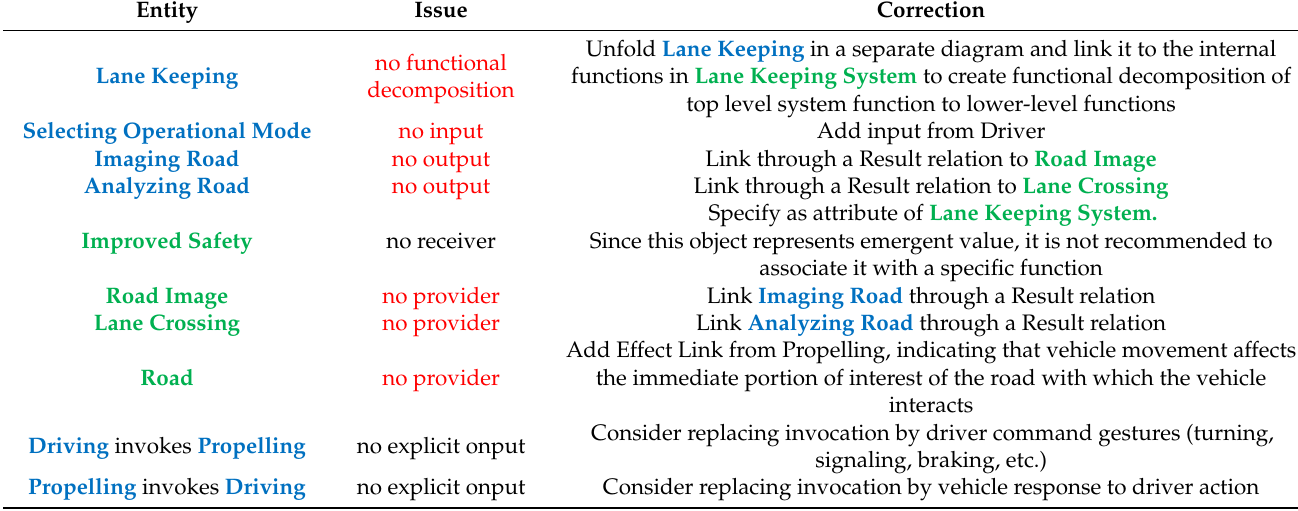
Table 9. Issues identified in the LKS model POP matrix and suggested corrections. Critical issues are marked in red.